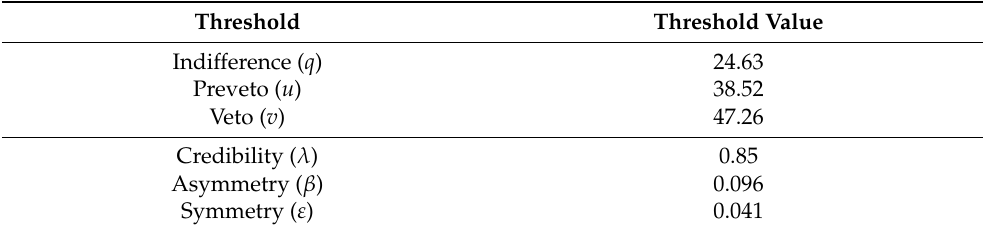
Table 17. Summary of preference thresholds influenced by satisfaction and